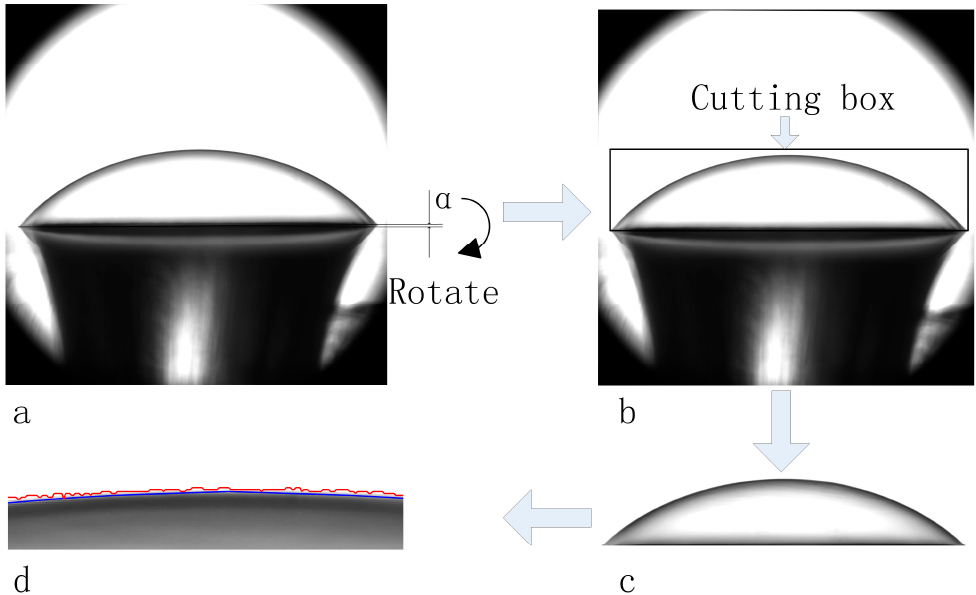
Figure 5. Flow chart for the proposed image processing method to obtain the outer boundary of the deformed membrane: ( a ) the original image with an image rotation angle α ; ( b ) the result of rotating and cutting the image using a region of interest (ROI) box; ( c ) the result of cutting; ( d ) the result of segmentation by thresholding method (red line) and the level set method (blue line). Figure 5d blue line is the result of the CV model segmentation for getting the outer boundaries of deformed membrane. It can be clearly observed that, the CV model can segment the two phase piecewise constant image (dark region as the PDMS membrane and the bright region as the background) with a smooth boundary. One thing should be additionally mentioned: the microscopy image of the PDMS membrane can be regarded as the blurred image of the “true” PDMS membrane, which was caused by the imaging system. Such blurred image can be restored by minimizing the ROF (Rudin, Osher and Fatemi) image restoration model as,